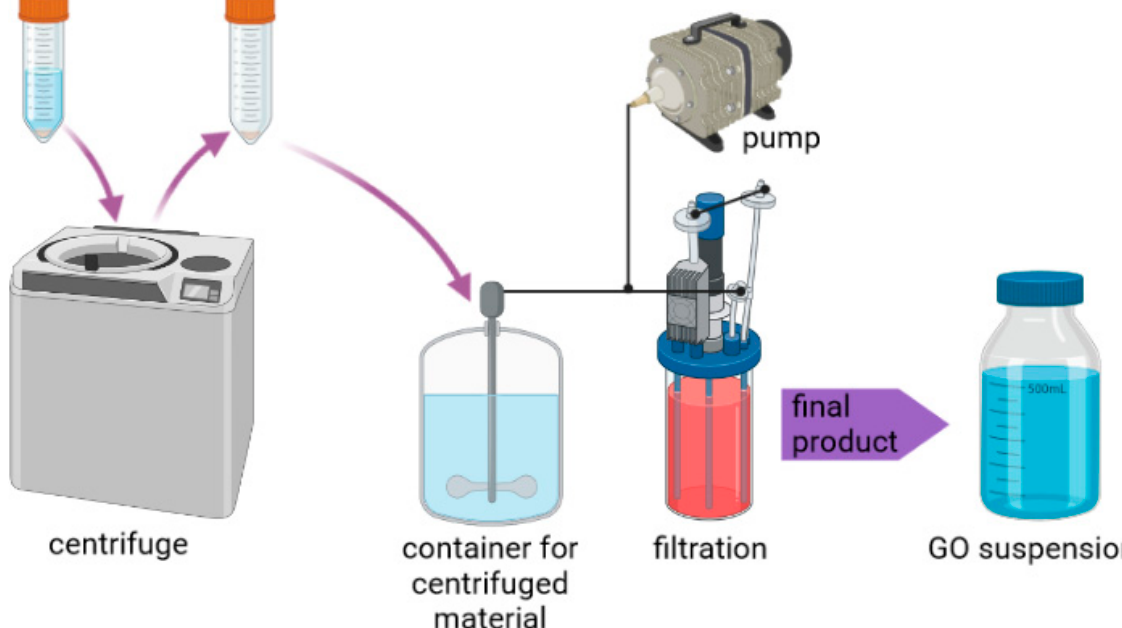
Figure 1. A scheme depicting purification procedure implemented in this study.